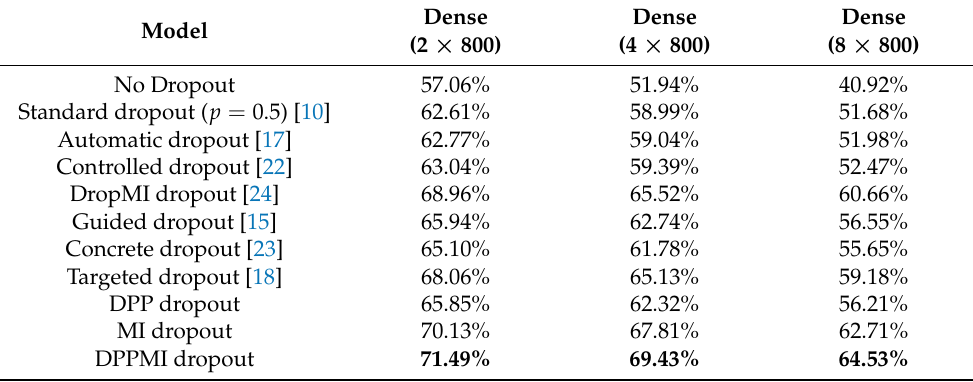
Table 2. Test accuracies of dense neural networks on CIFAR10 benchmark. The models’ structures are illustrated by (number of hidden layers × number of hidden units). The best test results are marked in bold fonts.